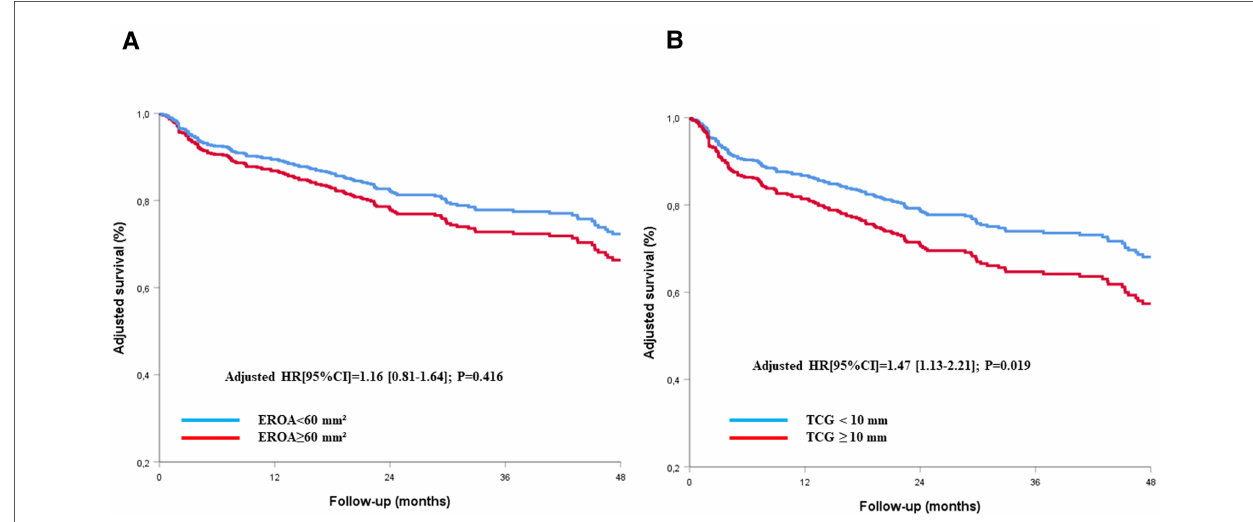
FIGURE 4 Cox-adjusted survival curves of patients with TR according to the de fi nition of very severe TR using EROA ( A ) or TCG ( B ). EROA, effective regurgitant ori fi ce area; TCG, tricuspid coaptation gap; TR, tricuspid